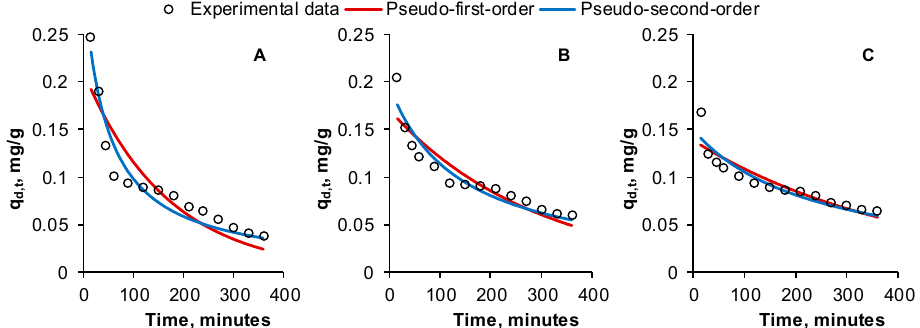
Figure 9. Desorption kinetics of Reactive Black 5 dye from the prepared adsorbent during the fi rst cycle ( A ), second cycle ( B ) and third cycle ( C ) (RB volume: 30 mL, RB initial concentration: 30 mg/L, eluent volume: 30 mL, eluent concentration: 1 M, adsorbent amount: 3 g, contact time: 6 h, temper- ature: 40 °C).